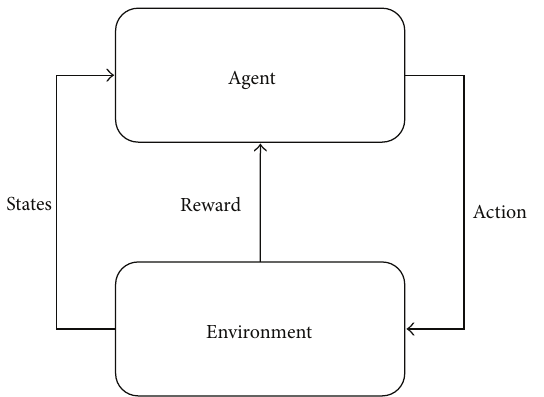
Figure 3: Model of the reinforcement learning.